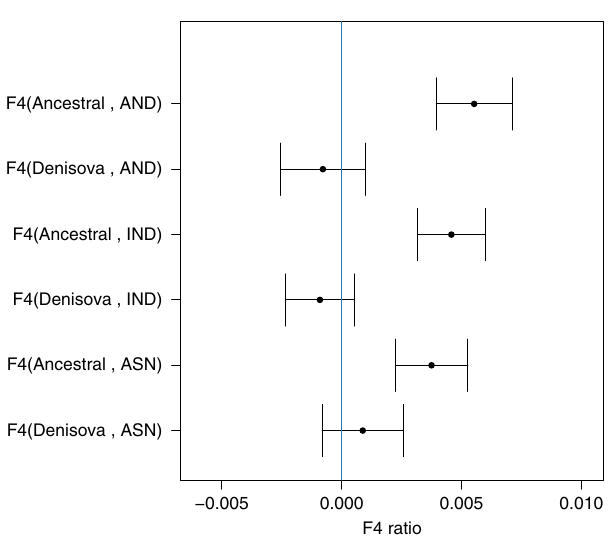
Fig. 1 Increase of Neanderthal ancestry in Asians compared to Europeans. The introgression amount is calculated by the F4 ratio test. F4 (Outgroup, Altai; Europeans, X)/F4(Outgroup, Altai; Africa, Vindjia) where Outgroup can be either Denisova or Ancestral alleles from 1000 Genome and X is either East Asian (ASN), Indian Tribal (IND) or Andamanese (AND). In the y axis to make it short we only mention F4(Outgroup, X) as the other populations remain constant for all the F4 ratio tests. In the x axis we have the amount of F4 ratio and the standard error is denoted by bars (standard error was calculated by Jackknife method using 555 blocks). The blue line